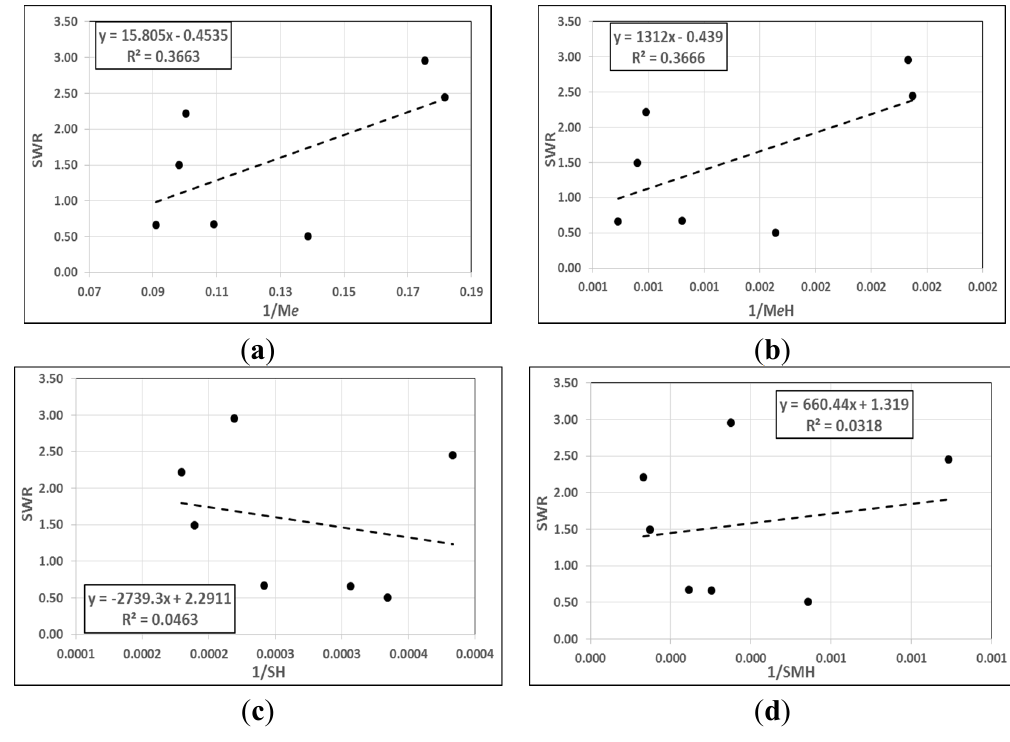
Figure 5. Correlation between the combined mechanical properties and SWR of